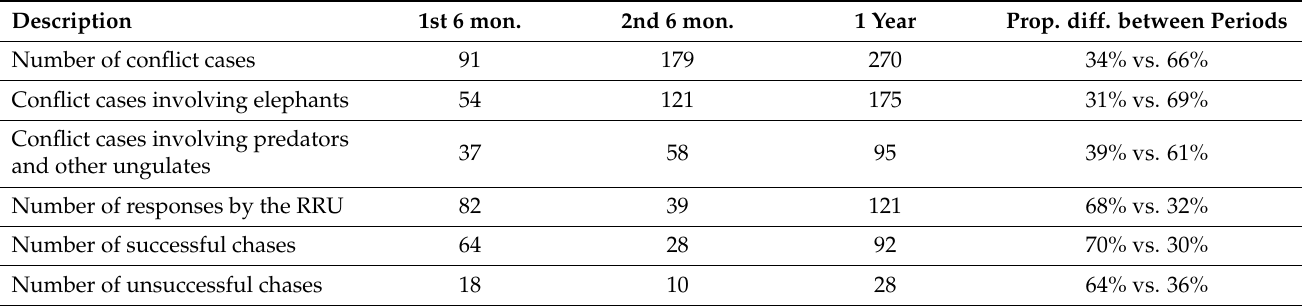
Table 4. The metrics of the RRU in operation within southern Mozambique over a 12-month period with the proportional difference in the categories over time and as divided int6 two six-month periods to evaluate the progress made to date in terms of mitigating